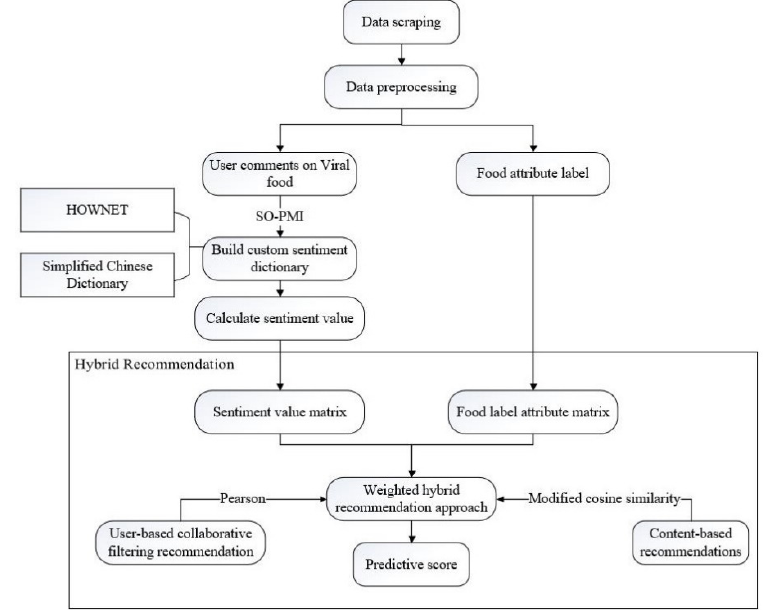
Figure 1. The technical route of the hybrid recommendation approach. The proposed hybrid recommendation approach is Hybird = w*CB + (1 −